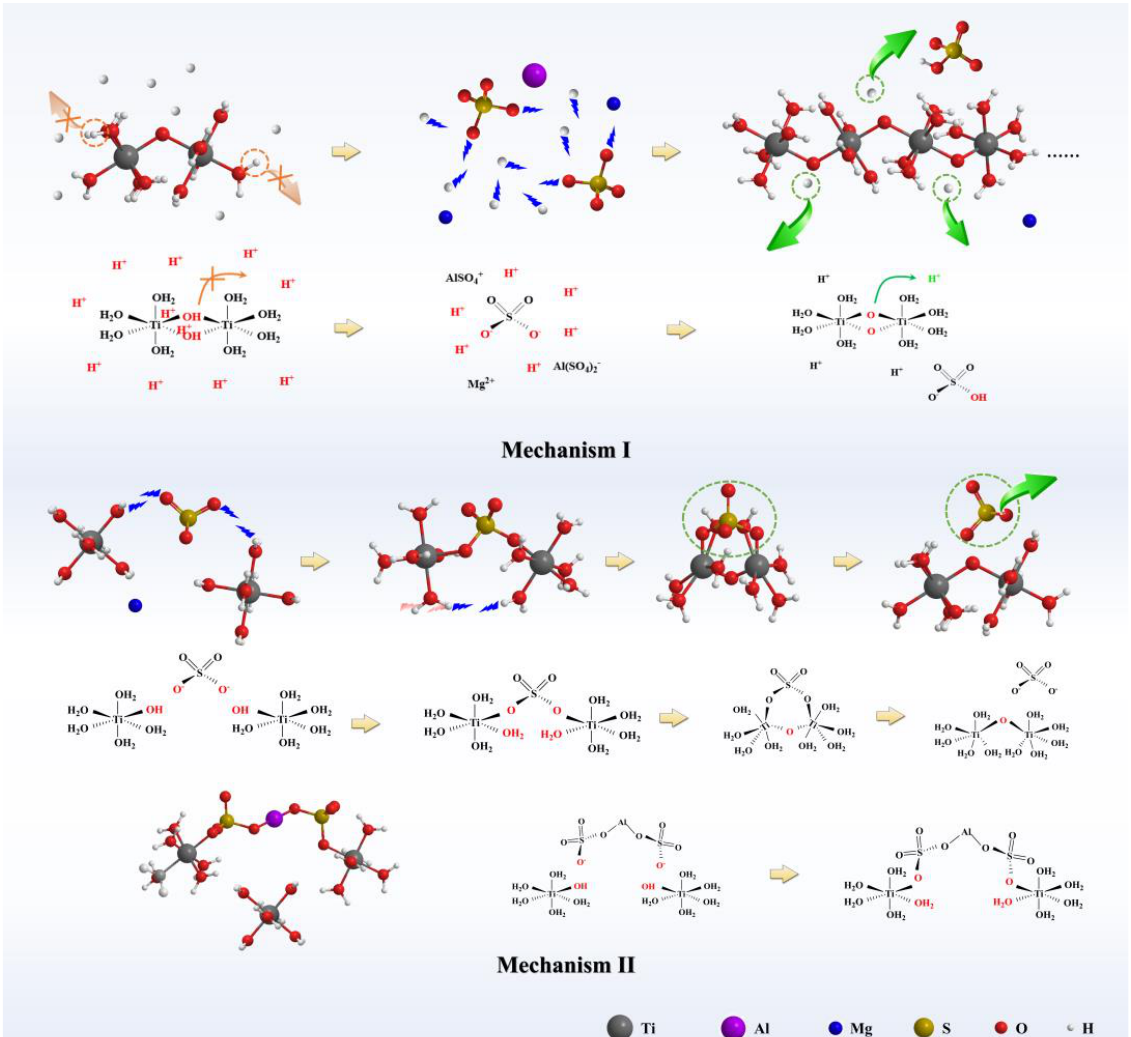
Figure 7. Influence mechanism of MgSO 4 and Al 2 (SO 4 ) 3 on the hydrolysis of TiOSO 4 .